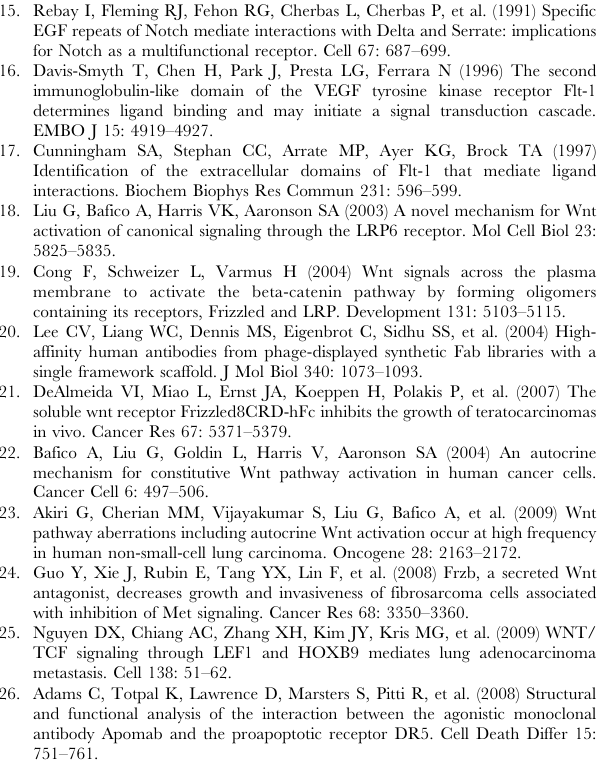
Figure S3 Whole but not one-armed antibody crosslinks LRP6 at the cell membrane. HEK293 cells transfected for expression of both flag- and HA-tagged LRP6 were treated with the indicated antibodies, and LRP6-flag was immunoprecipitated from cell lysates. After elution, LRP6-flag complexes bound to LRP6 antibodies were affinity purified using Protein A/G resin and subjected to Western analysis for crosslinked LRP6-HA. As